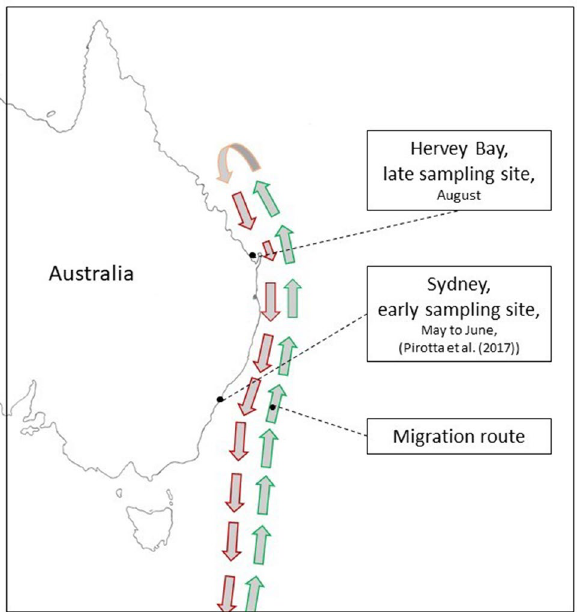
Figure 1. Map of the sampling sites off the coast of Sydney and Hervey Bay, Australia. The green arrows represent the northern leg and the red arrows the southern leg of the annual migration of the East Australian humpback whales. We drew this figure according to the information provided in Franklin 32